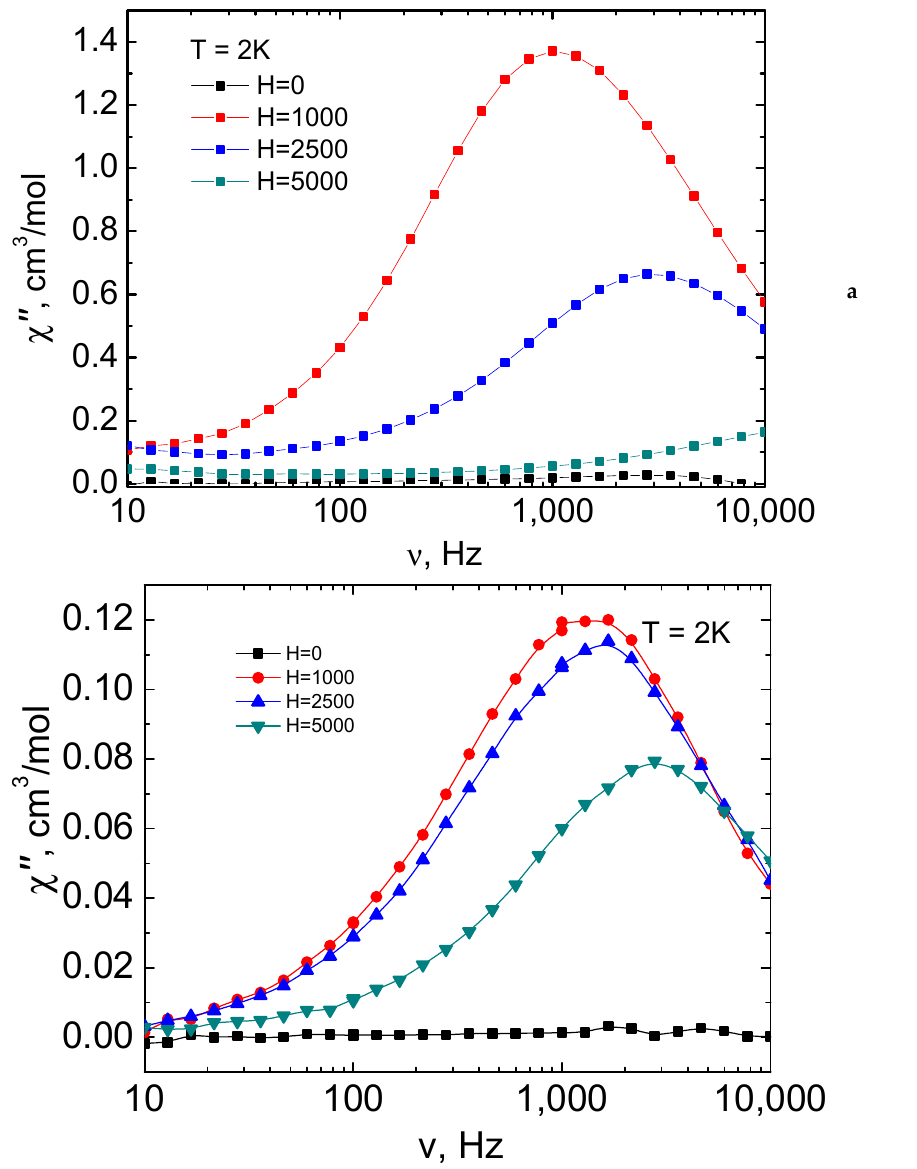
Figure 6. Frequency dependences of the imaginary χ″ components of magnetic susceptibility of complex 4 ( a ) and 7 ( b ) in various applied fields at 2 K.